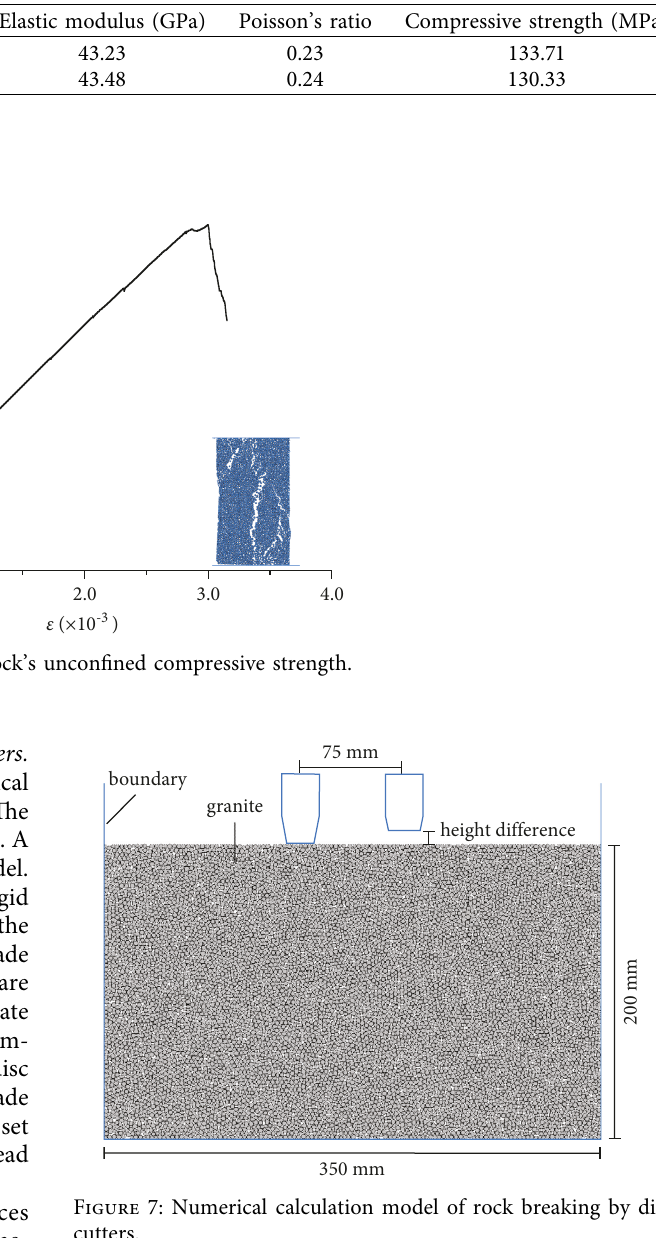
Table 2: Physical and mechanical parameters of granite.